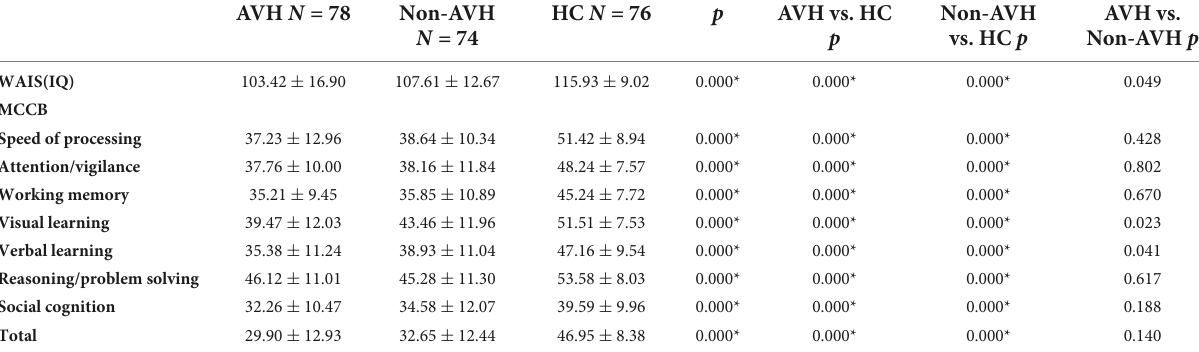
TABLE 2 Comparisons of IQ and cognitive function in three groups.